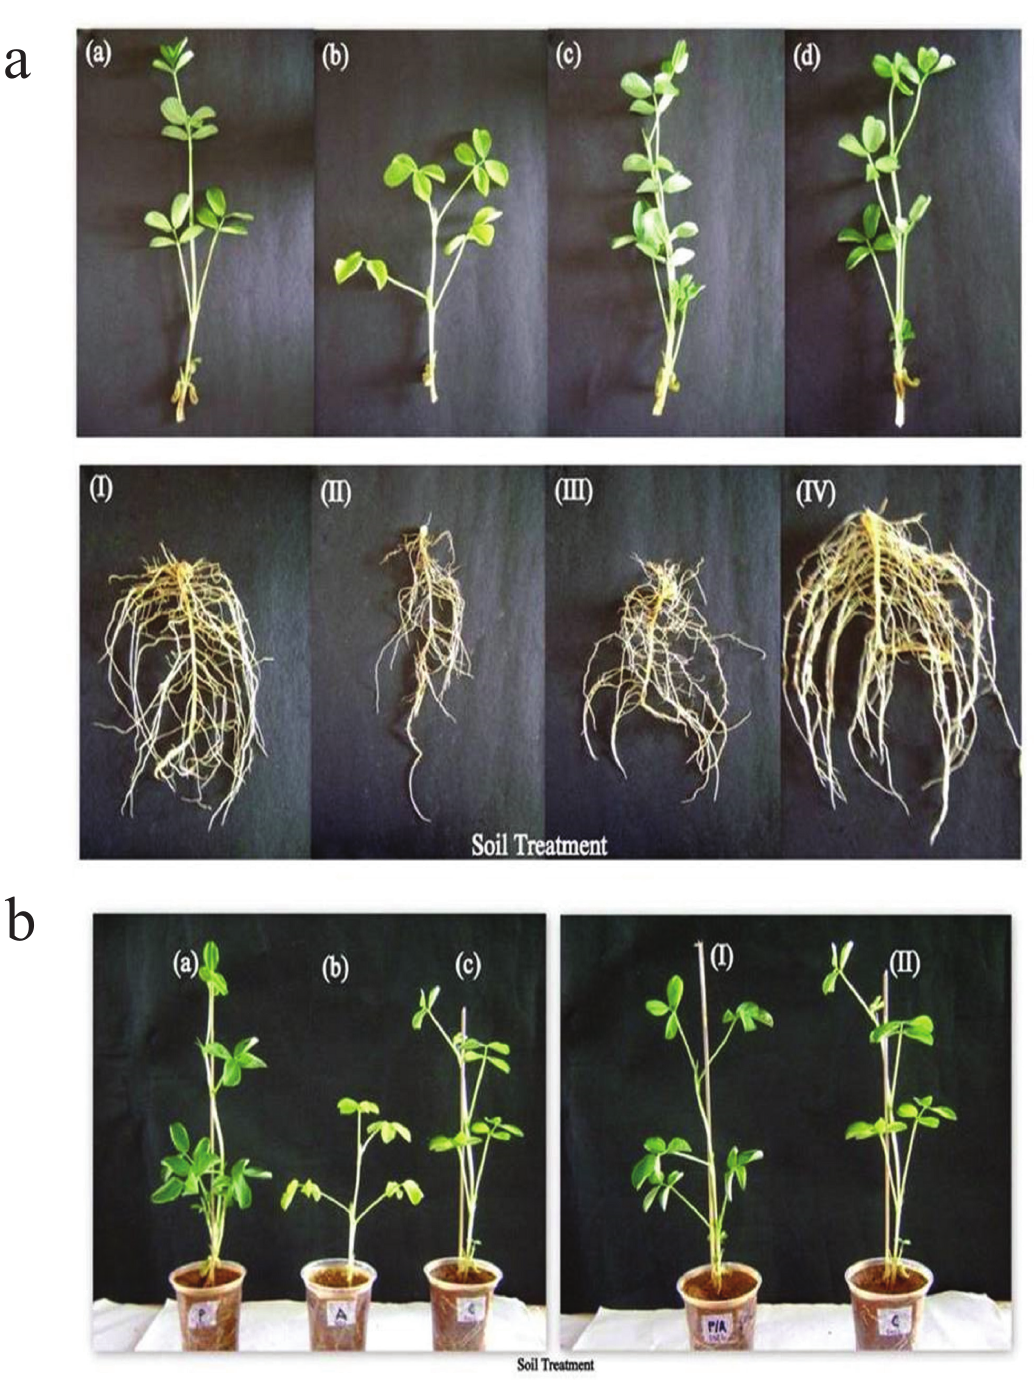
Figure 2 - Growth of groundnut plants under soil application of